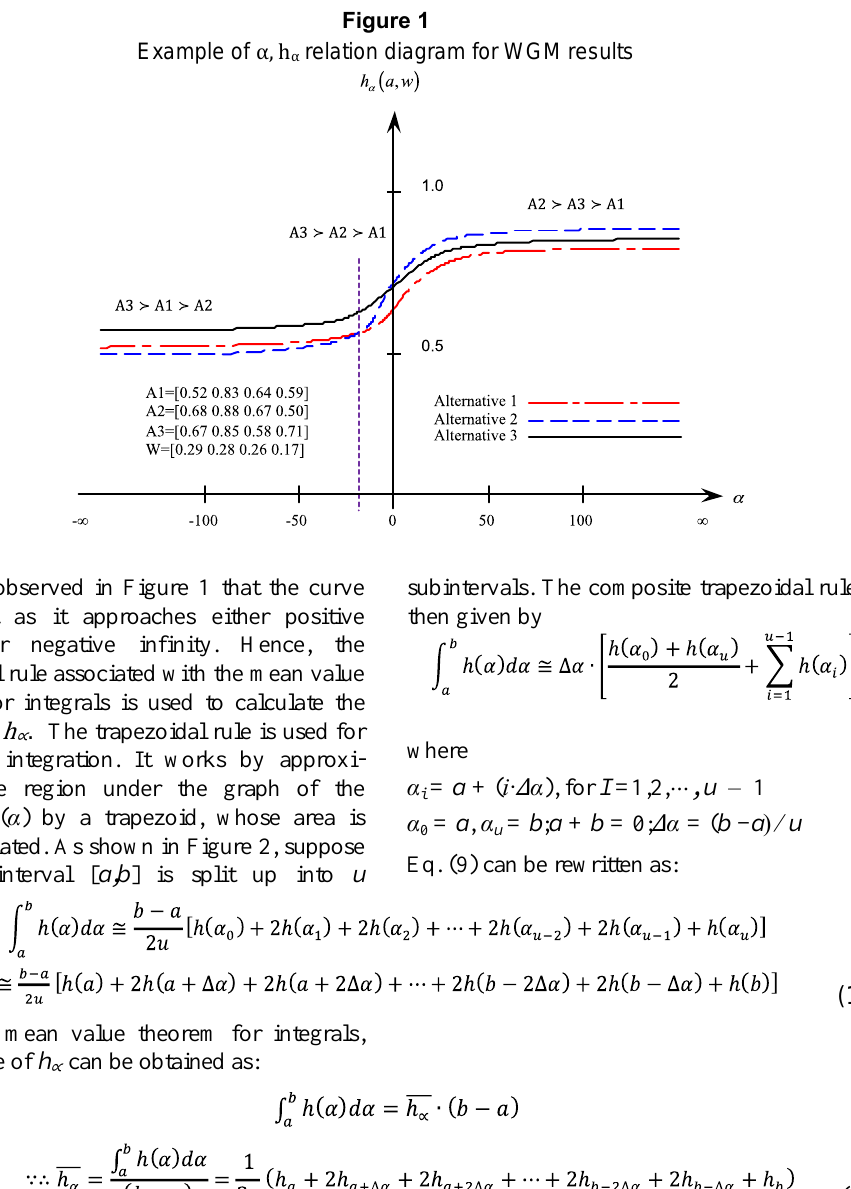
Example of α, h α relation diagram for WGM